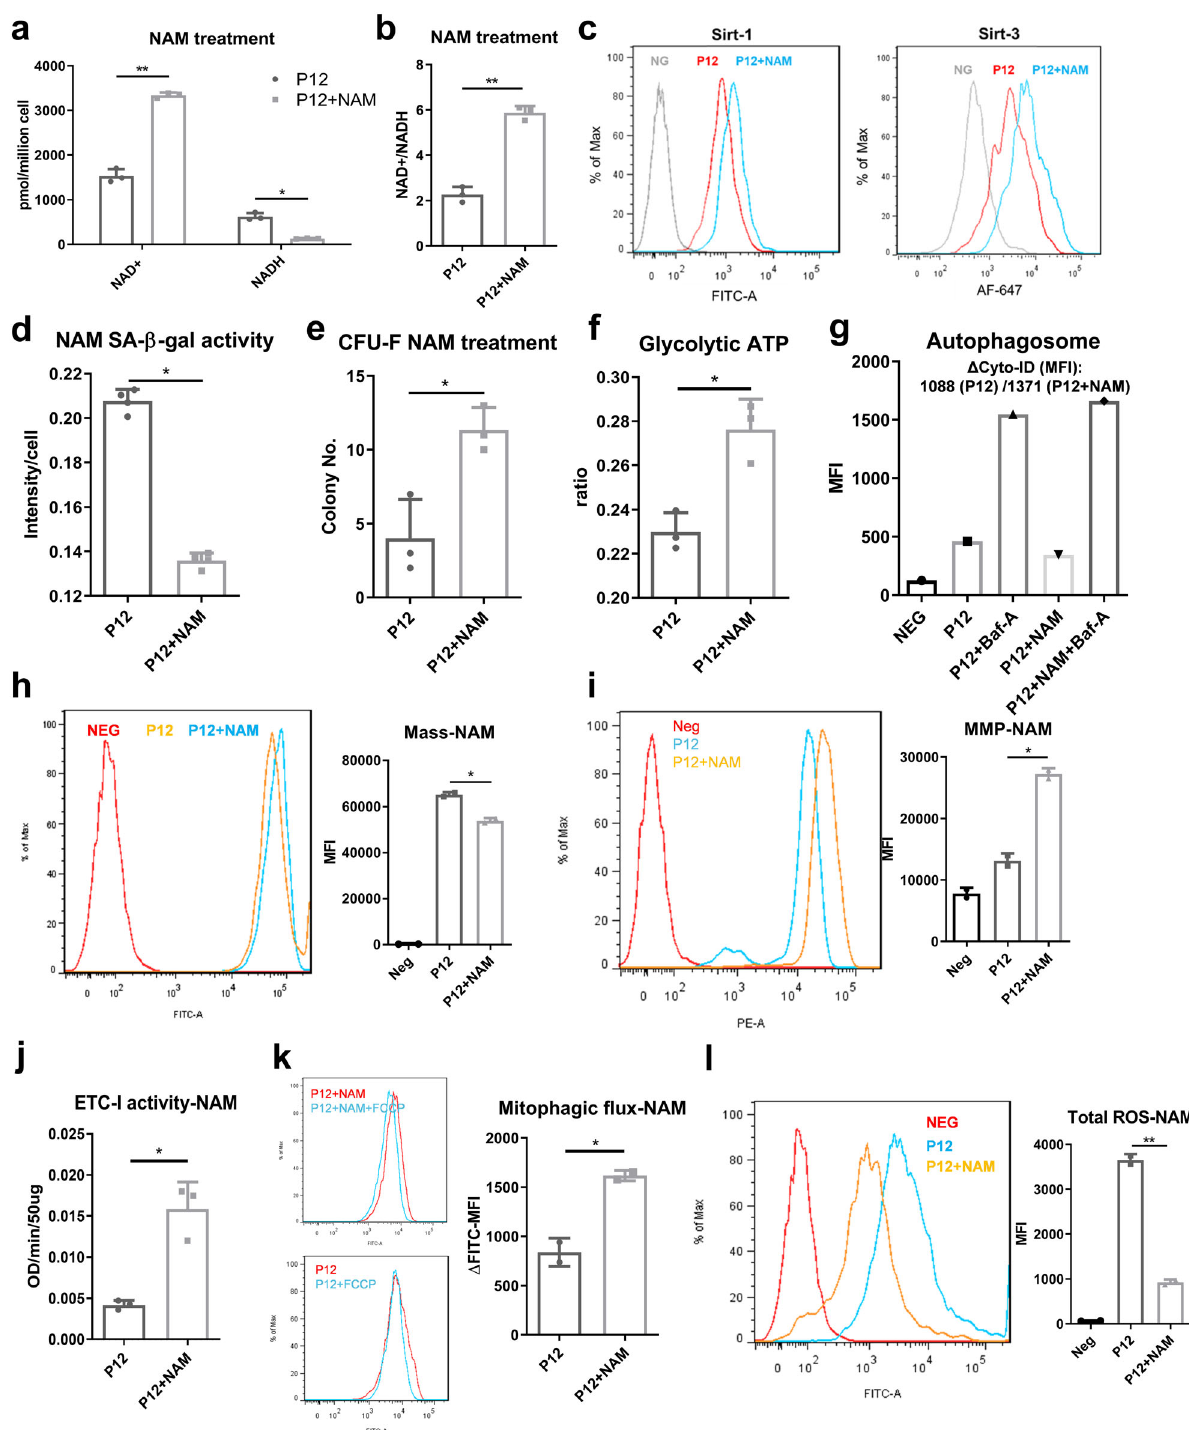
Fig. 6 Repletion of NAD + via NAM restores mitochondrial function and preserves stem cell function in long-term cultured human mesenchymal stem cells (hMSCs). Senescent hMSCs at late passages were treated with NAM for 96 h. a NAD level was increased and NADH level was decreased. b NAD + /NADH ratio was increased. c Sirt-1 and Sirt-3 expressions were both increased. d SA- β -gal activity was decreased. e Colony-forming ability (CFU-F) and f glycolytic ATP ratio were also increased. g Basal autophagy was restored in senescent hMSCs after NAM treatment. MFI mean fl uorescence intensity. Mitochondrial fi tness was restored. h Mitochondrial mass was decreased. i Mitochondrial transmembrane potential (MMP) and j electron transport chain complex I (ETC-I) activity was increased. k Mitophagy ability was restored. FCCP mitochondrial uncoupler carbonilcyanide p-tri fl ouromethoxyphenylhydrazone. l Total reactive oxygen species (ROS) level was reduced as determined by fl ow cytometry. Biological replicates ( n ): n = 3. * p < 0.05; ** p <